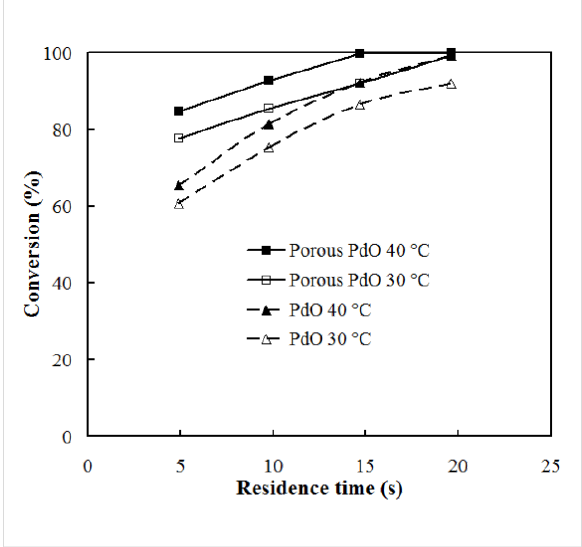
Figure 4: Effect of residence time on the conversion of 0.01 M p -nitro- phenol with 0.1 M formic acid at 30 °C and 40 °C using PdO and porous-PdO-coated tubular reactors.